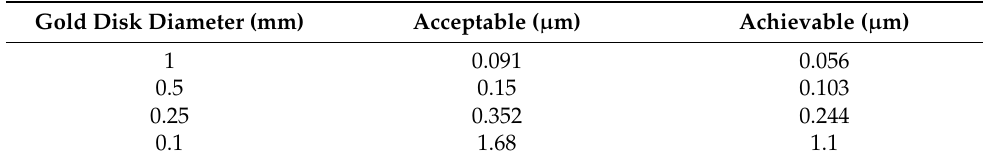
Table 3. Acceptable and achievable EUREF performance